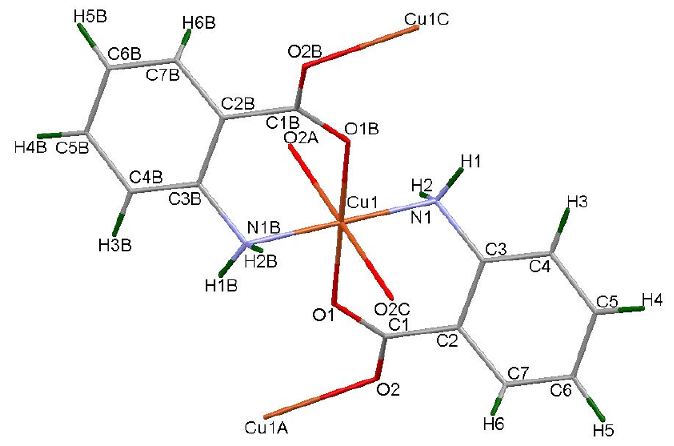
Figure 2. Crystal structure of catena(bis(o-aminobenzoato-copper(II))) [14].